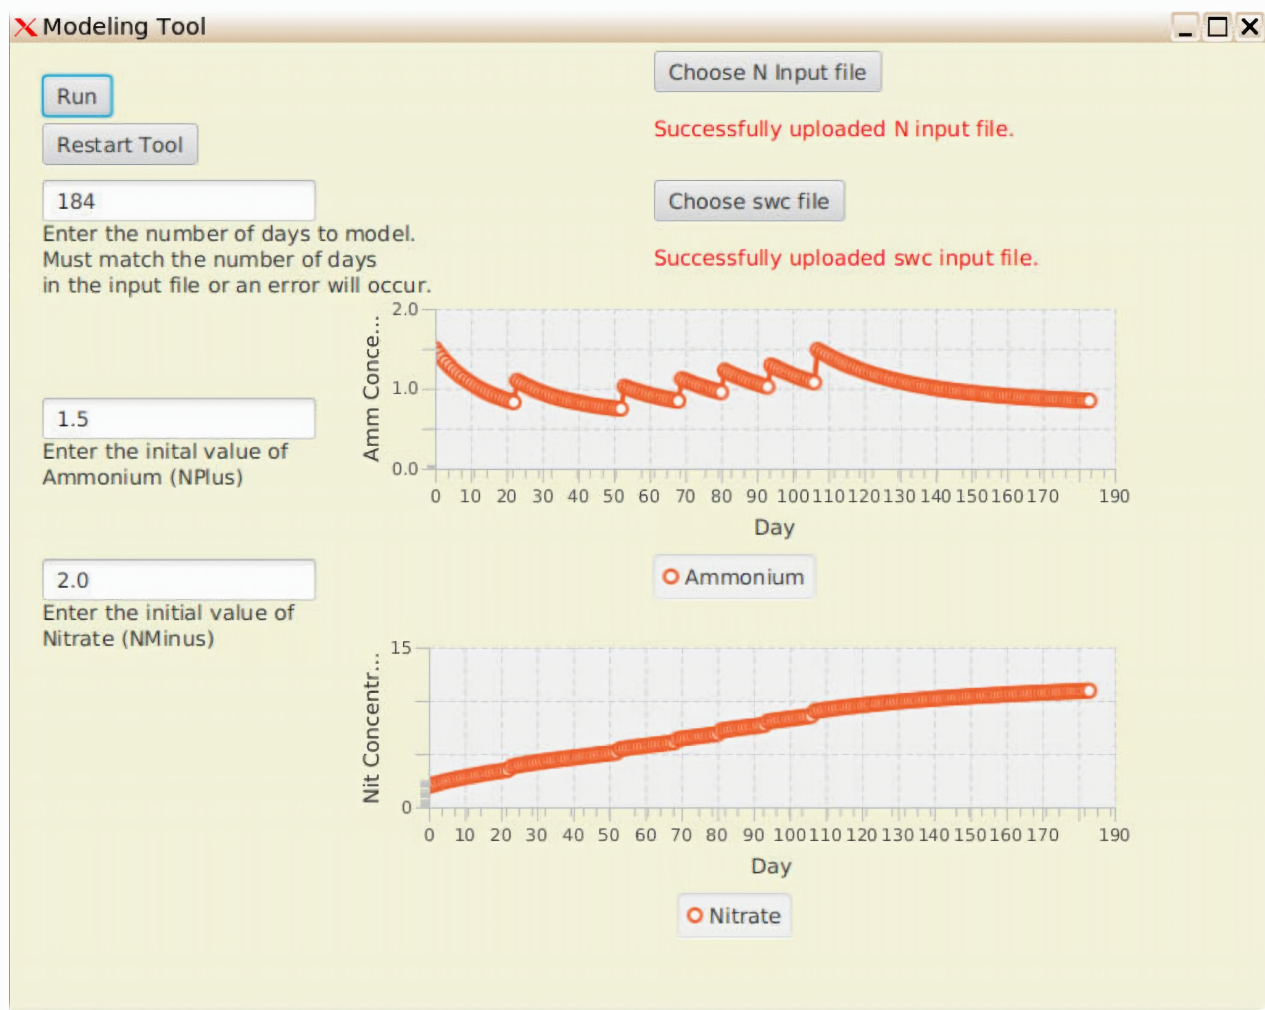
Figure 8. MyGeoHub implementation interface and